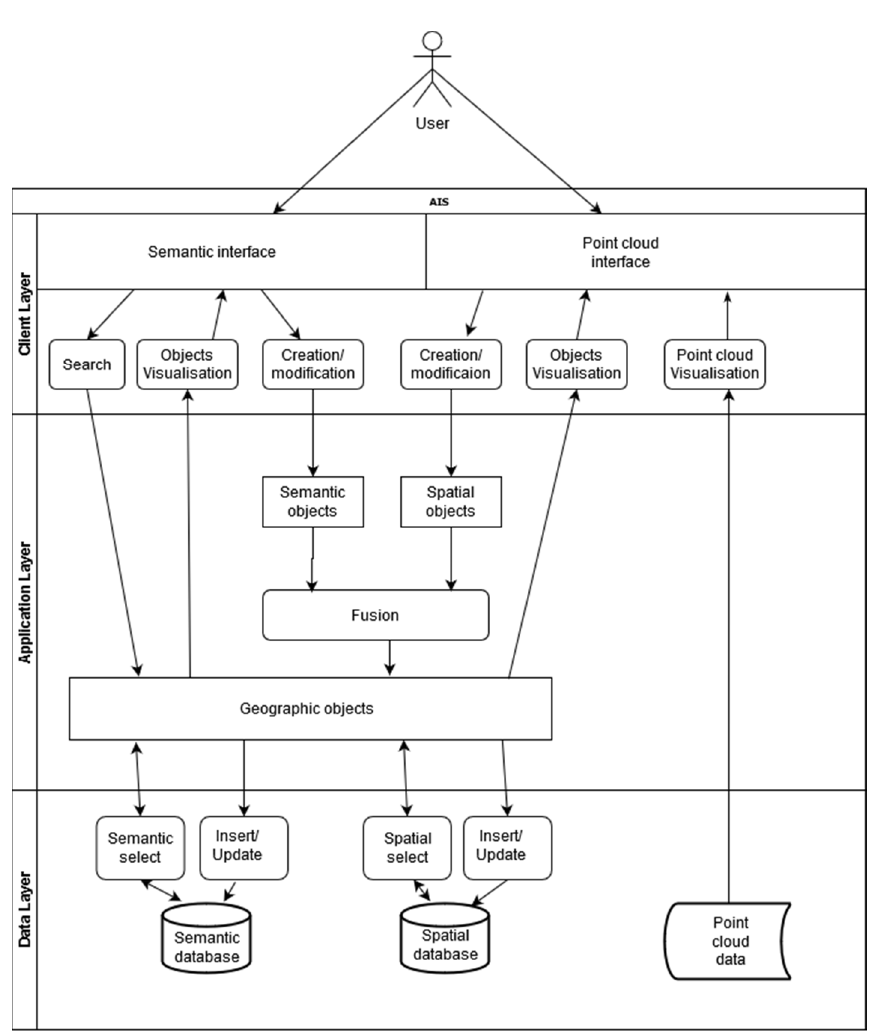
Figure 11. Use cases diagram of the HIS.